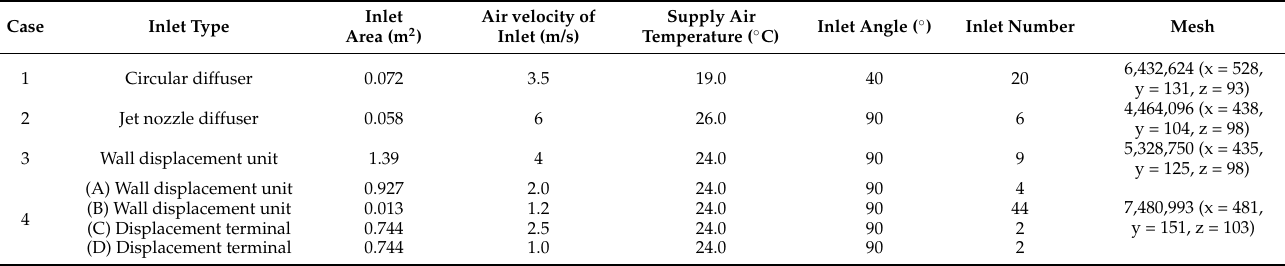
Table 4. The settings of inlet in each case.